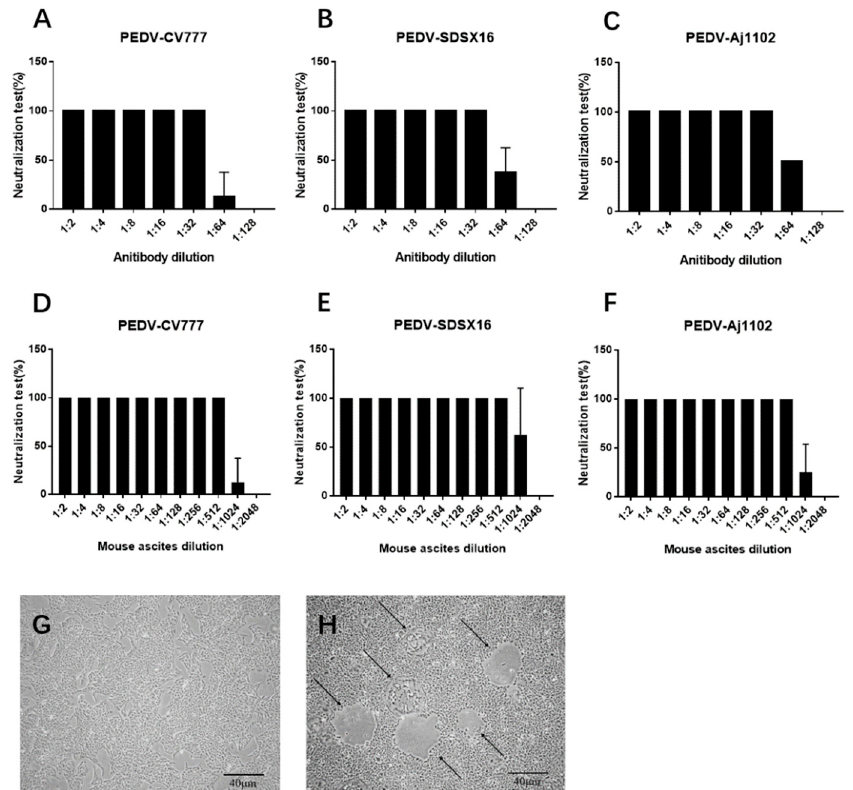
Figure 4. The neutralization of PEDV by anti-PEDV mAb-2 from hybridoma supernatant and mouse ascites. ( A – C ) Neutralization of PEDV-CV777, PEDV-SDSX16 and PEDV-Aj1102 by anti-PEDV mAb-2 hybridoma supernatant. ( D – F ) Neutralization of PEDV-CV777, PEDV-SDSX16 and PEDV-Aj1102 by anti-PEDV mAb-2 mouse ascites. ( G ) Morphology of Vero cells after incubation for 72 h with anti-PEDV mAb-2 and PEDV. ( H ) Morphology of Vero cells after incubation for 72 h with PEDV only. The black arrow indicates the presence of syncytial bodies. Each column represents the average of triplicates, and each error bar indicates the standard deviations.